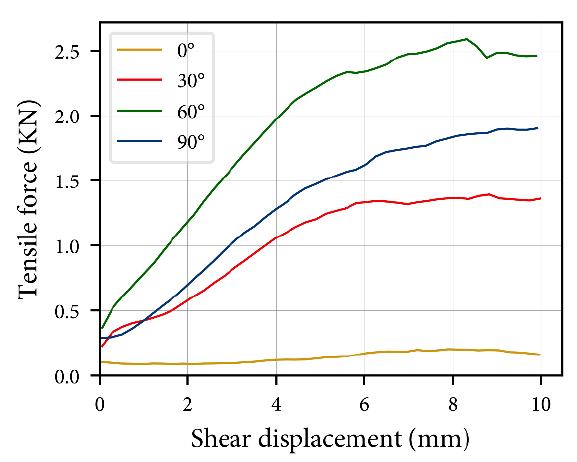
Figure 14. Evolution of fiber tensile force.